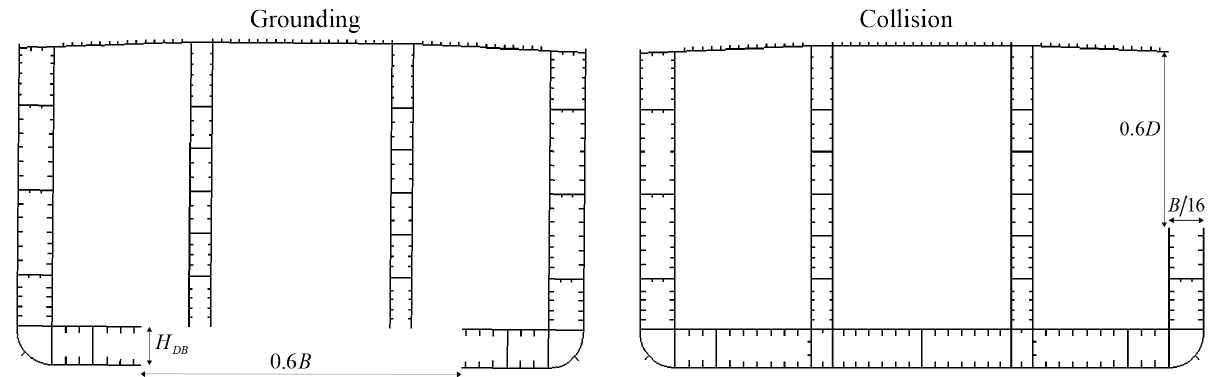
Figure 9. Assumed grounding and collision damage extents in